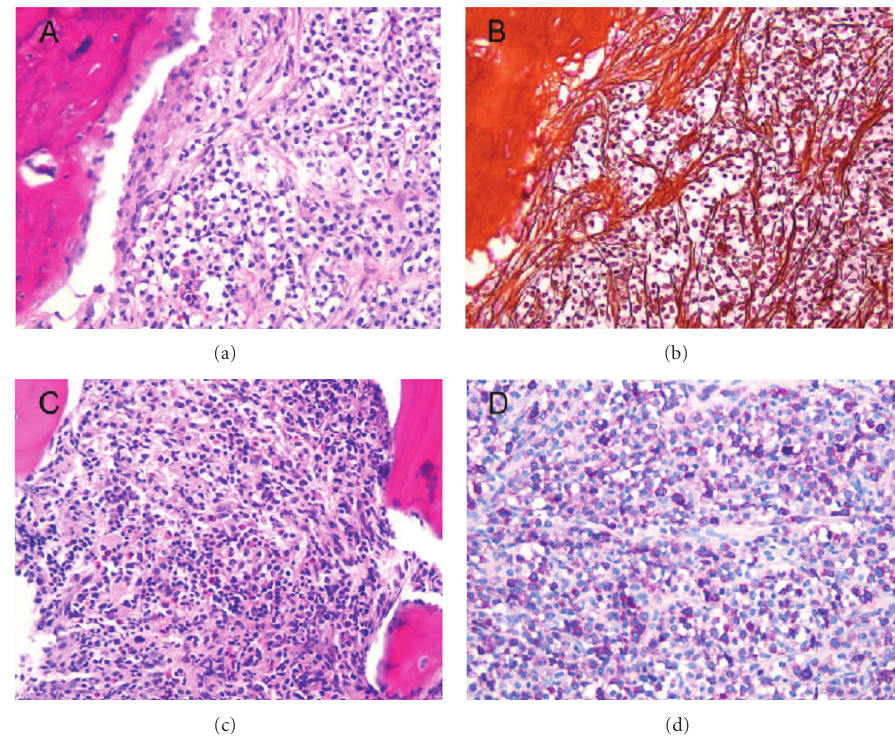
Figure 2: Bone marrow specimen of the patient with systemic mastocytosis. (a) Di ff use infiltration of the bone marrow with neoplastic mast cells and massive displacement of hematopoetic cells (HE). (b) Induction of myelofibrosis by neoplastic cells (modified Gomori stain). (c) Residual hematopoiesis besides neoplastic infiltrates (HE). (d) Giemsa staining shows cytoplasmatic granules of neoplastic mast cells 200 × .